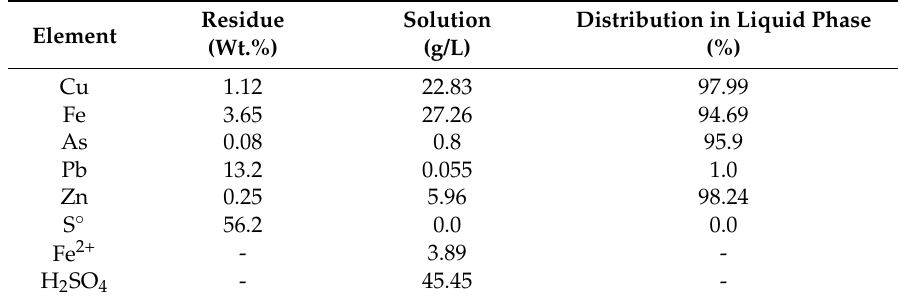
Table 6. Chemical analysis of the test 5 residue (Wt.%), chemical analysis of the solution (g/L) and the elemental distribution in the liquid phase (%) of the leaching process.